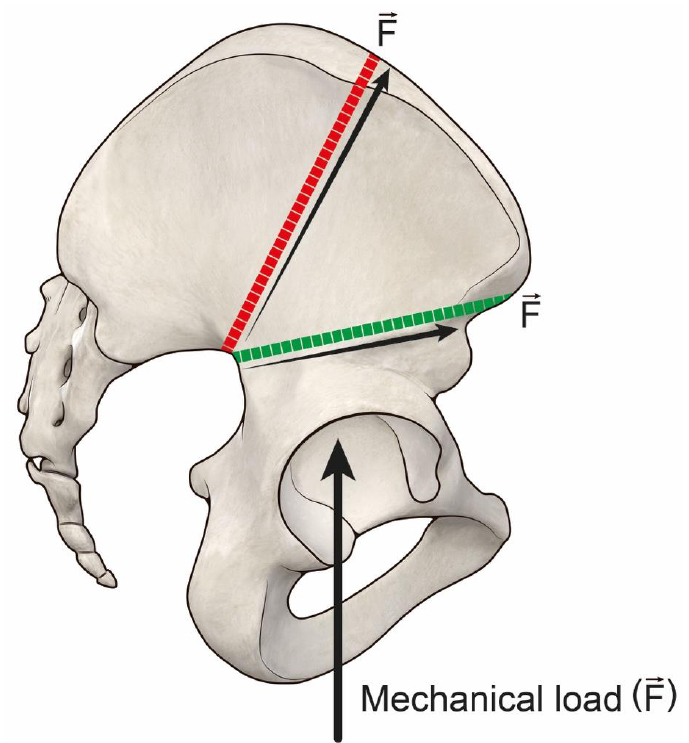
Figure 6. Shear stress vertical forces are less when the osteotomy line is made under the anterosuperior iliac spine.